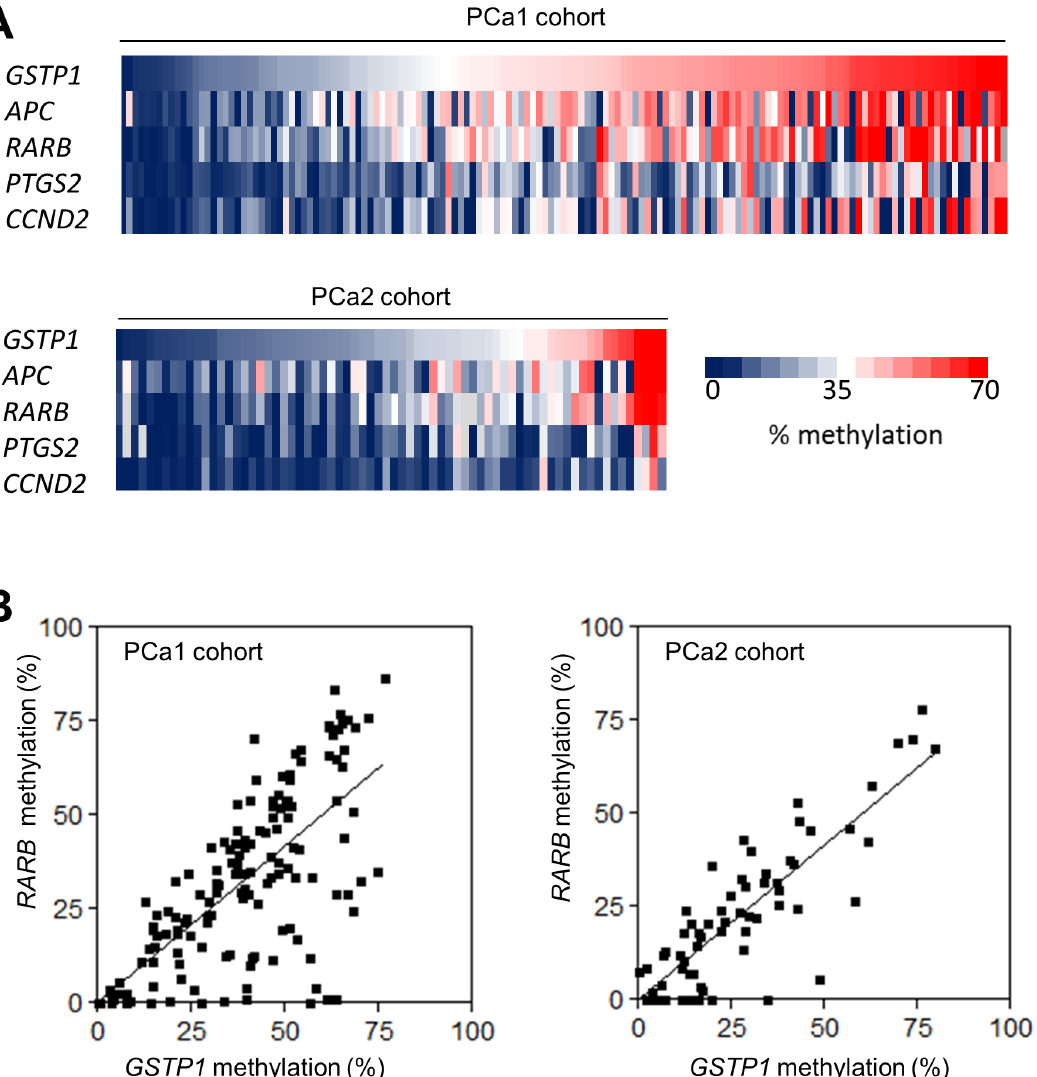
Fig 2. Range of DNA marker methylation in patients with high-risk PCa. Color-scaled representation of DNA methylation in tumors from the PCa1 and PCa2 cohorts. (A) The patients were ordered according to their GSTP1 methylation value. The % of methylation of the other 4 marker genes is also shown. Grey boxes indicate missing values. (B) Scatter plots of the correlation between GSTP1 methylation and RARB methylation in PCa1 (left panel) and PCa2 (right panel) cohorts.